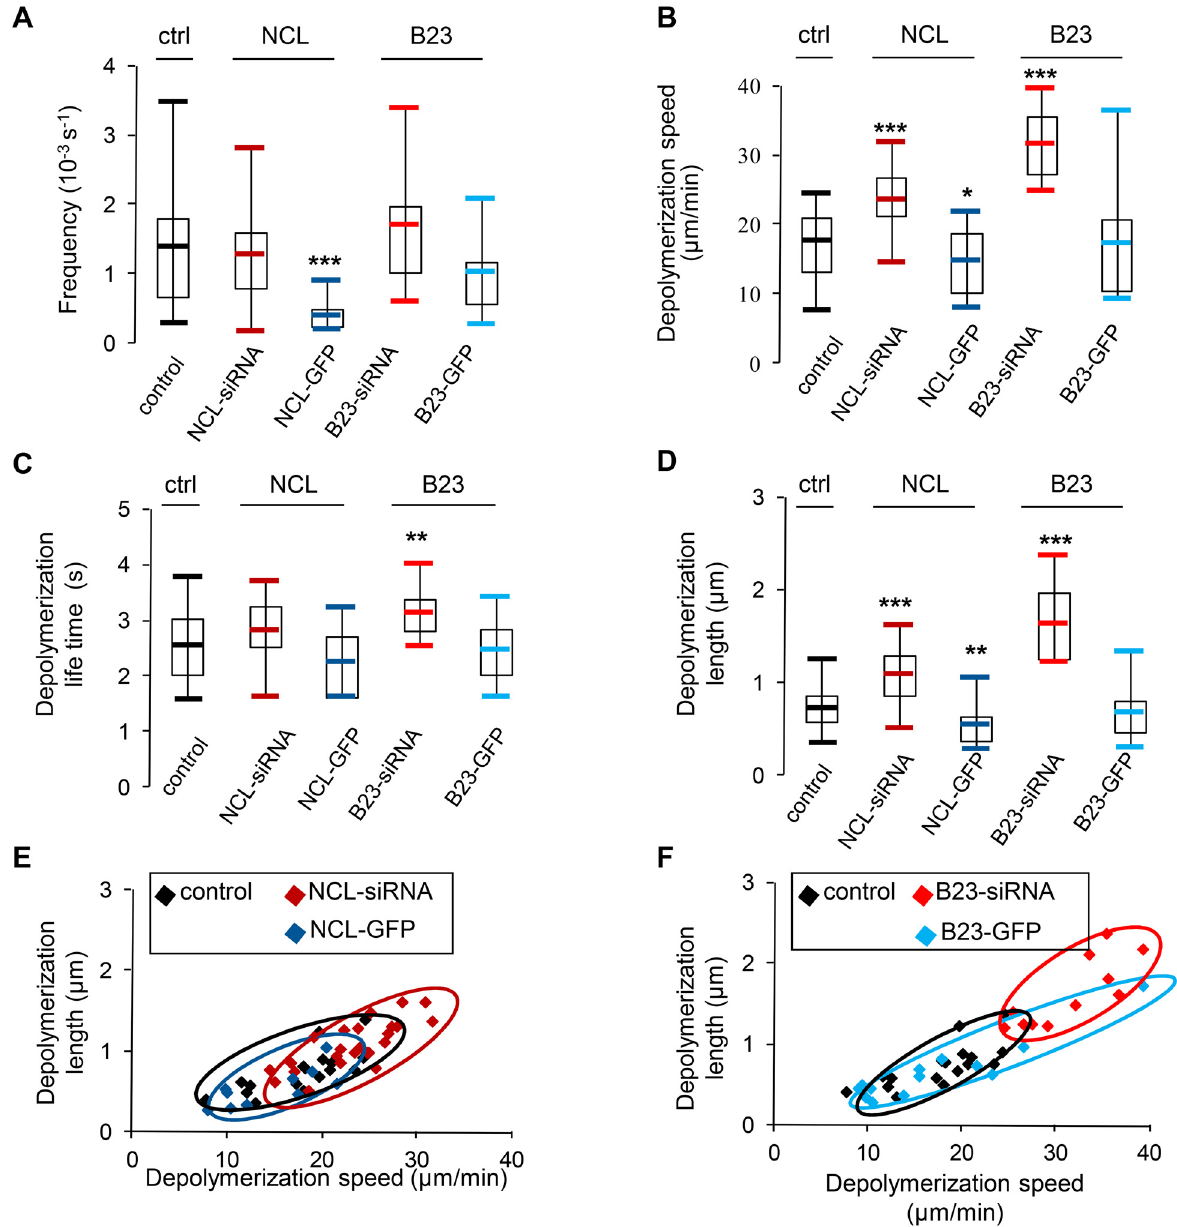
Fig 6. Nucleolin expression affects microtubule catastrophes. Analysis of catastrophe events in control [black], nucleolin depleted [dark red], nucleolin over expressing [dark blue], B23 depleted [light red] and B23 over expressing cells [light blue]. The asterisks indicate that the mean value differs from the control condition with the Wilcoxon-Mann-Whitney two-sample rank test at different significance levels: 10% ( * P < 0.1), 5% ( ** P < 0.05), 0,5% ( *** P < 0.005). (A) Catastrophe frequency (10 -3 s -1 ) is calculated by dividing the time microtubules spend in growth (B)-(D) Catastrophe parameters are deduced by linking two temporally adjacent growths spatially spaced out by a Bgap (Backward Gap). The mean values of speed (B), life time (C) and length (D) during catastrophes were measured in each cell and reported on the graphs. (E) and (F): 2D graphs showing the repartition of the cells according to depolymerization speed (x-axis) and length (y-axis). Control [black], nucleolin over expressing [dark blue] and nucleolin depleted [dark red] (E) or B23 over expressing [light blue] and B23 depleted [light red] (F) cells are represented by the squares. (A-D) Cells were individually analyzed (control: 17 cells; NCL-siRNA: 24 cells; NCL-GFP: 10 cells; B23-siRNA: 11 cells; B23-GFP: 14